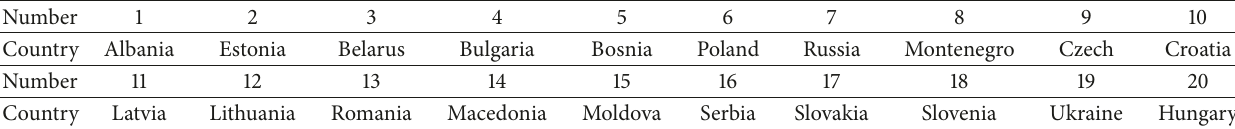
Table 7: Number 20 countries in